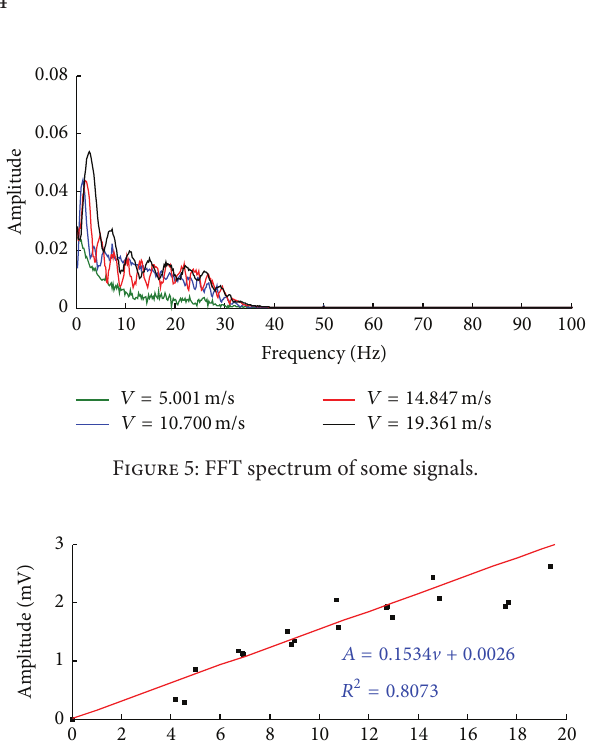
Figure 6: Relationship between the true TEM peak value and the impact velocity.